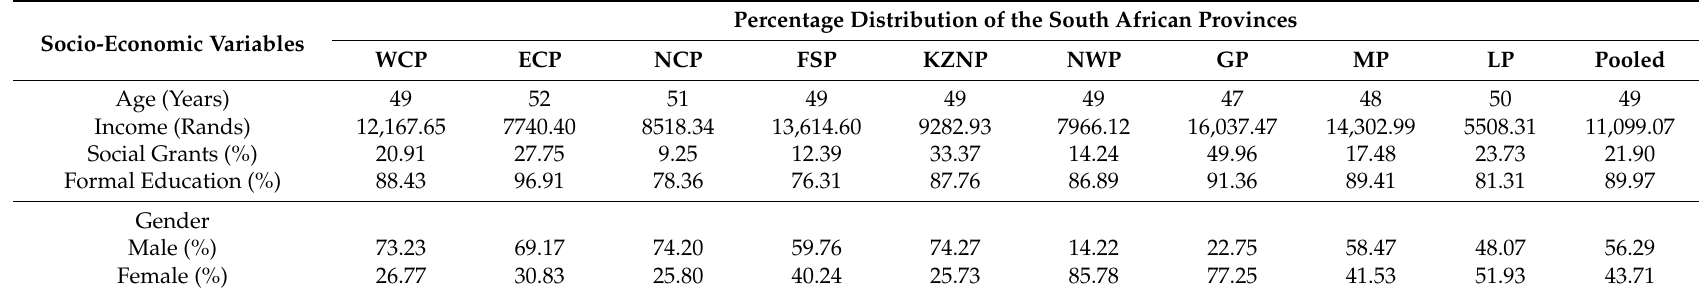
Table 1. Distribution of respondents by selected socio-economic characteristics of household